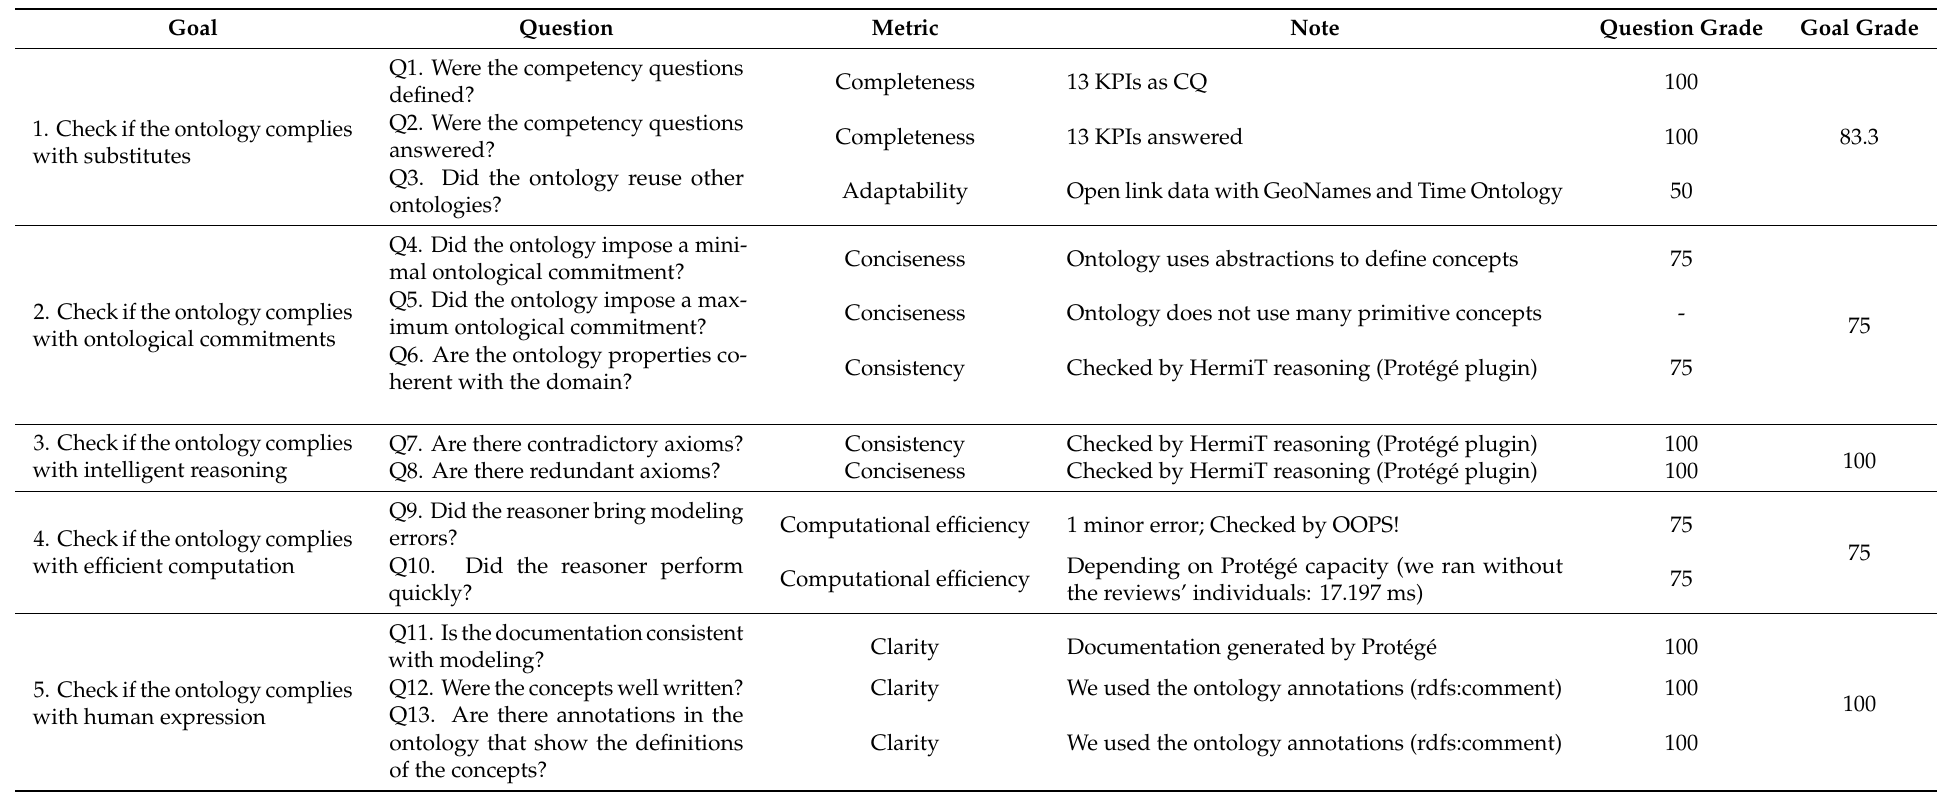
Table 9. Applying the goal–question–metric approach from the FOCA methodology on the TTS ontology